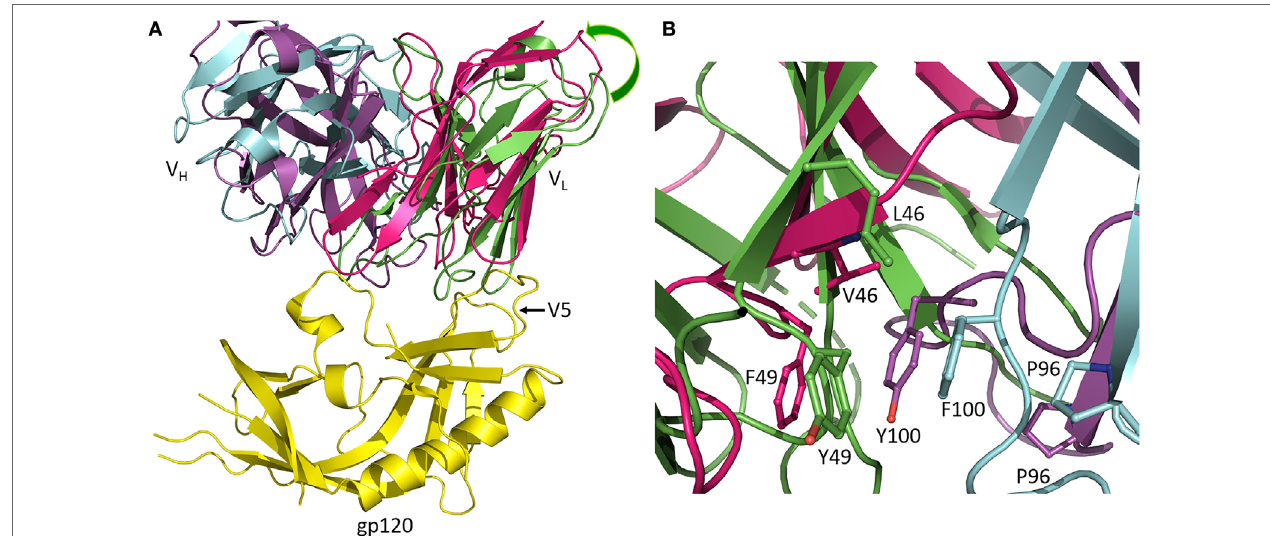
FiGURe 2 | Reorientation of V L and V H domains in response to viral escape mutations. (A) Superposition of the germ line precursor of CH103 (V L and V H domains are green and cyan, respectively) (4QHL) (14) onto matured CH103 (V L and V H domains are red and magenta, respectively) in complex with envelope glycoprotein gp120 (yellow) (4JAN) (13). During affinity maturation, a shift occurred in the orientation of V L with respect to V H . The shift is an adaptation to insertions in the gp120 V5 loop during infection. Movement of V L away from gp120 enables accommodation of the V5 insertion. (B) Close-up view of the V L /V H interface in the vicinity of the V L Leu46 → Val mutation showing changes in interdomain contacts and rearrangement of V H